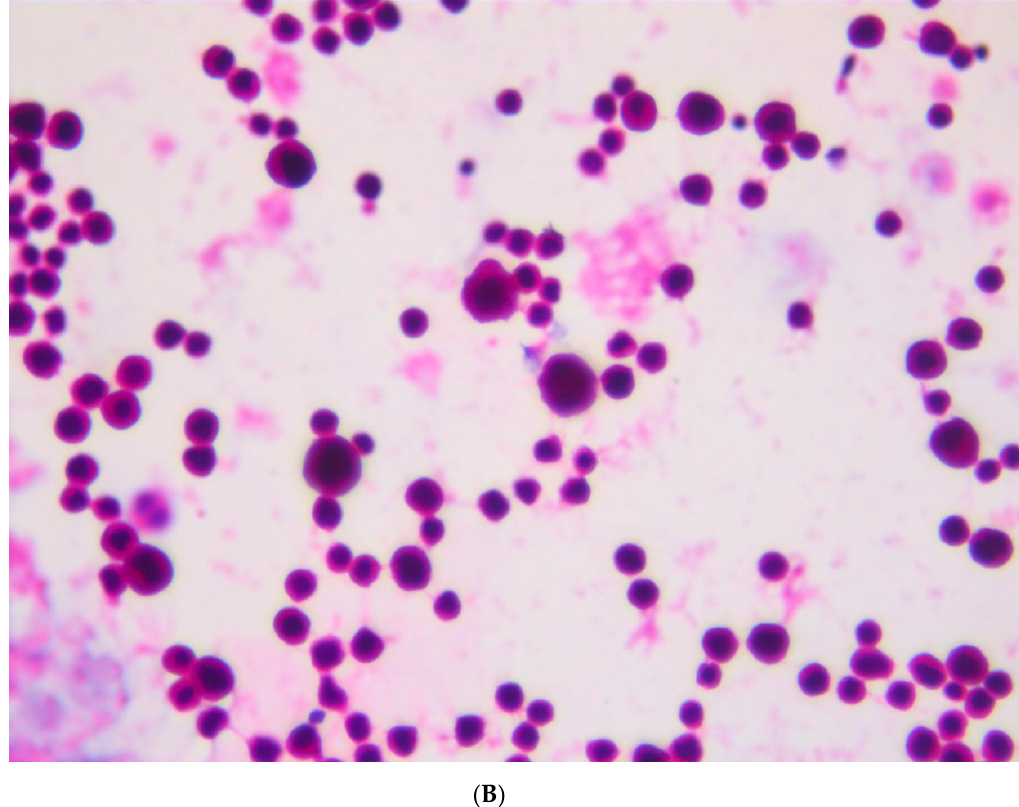
Figure 3. Cerebrospinal fluid cytology examination: massive presence of carcinomatous cells. Hematoxylin and Eosin staining; magnification 20× ( A ) and 40× ( B ).